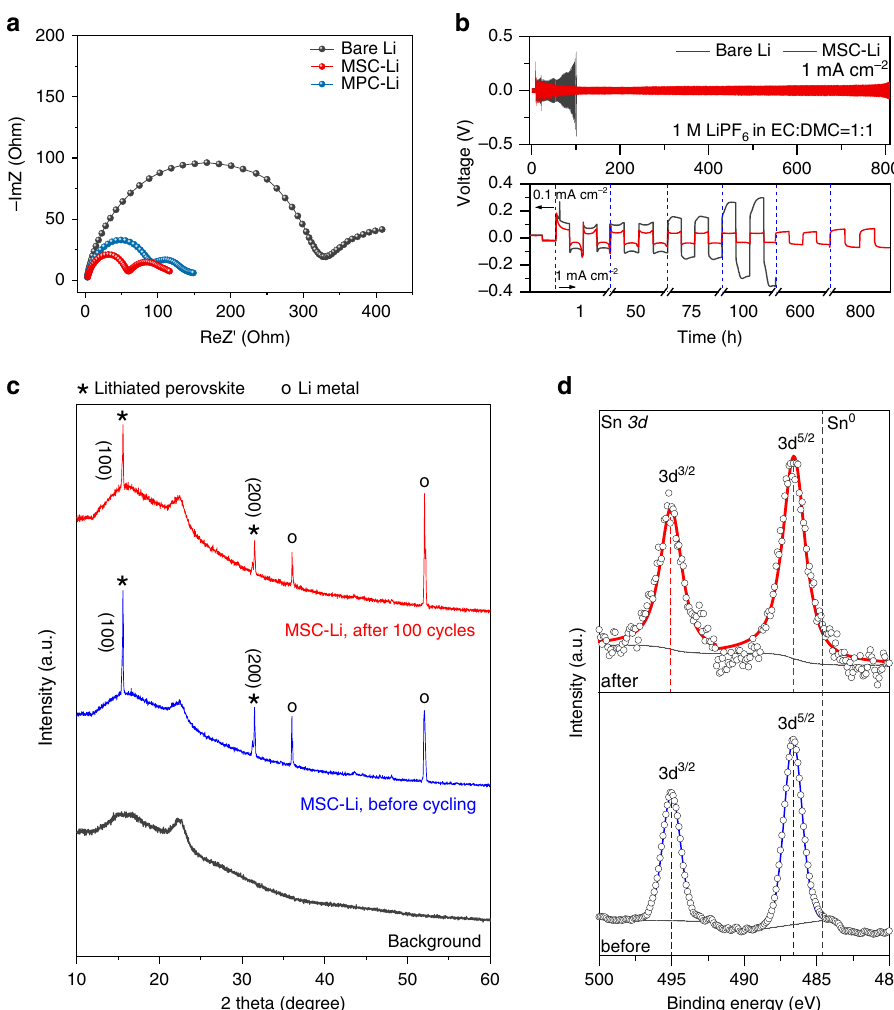
Fig. 3 Electrochemical stability of MSC-Li and MPC-Li. a EIS spectra of bare Li, MSC-Li and MPC-Li. b Galvanostatic voltage curves (top) of bare Li and MSC-Li tested with a current density of 1 mA cm − 2 for 1 mAh cm − 2 , and the enlarged voltage curves during different periods (bottom). c XRD patterns of MSC-Li anode before cycling (blue) and after 100 cycles (red) to indicate the electrochemical stability and phase retention of lithiated perovskite during cycling, accompanied with the XRD pattern of sealing tape to isolate samples from air (black). d XPS spectra of the surface of MSC-Li anode before cycling (blue) and after 100 cycles (red) to prove that the perovskite solid-electrolyte interface stays on the top surface after